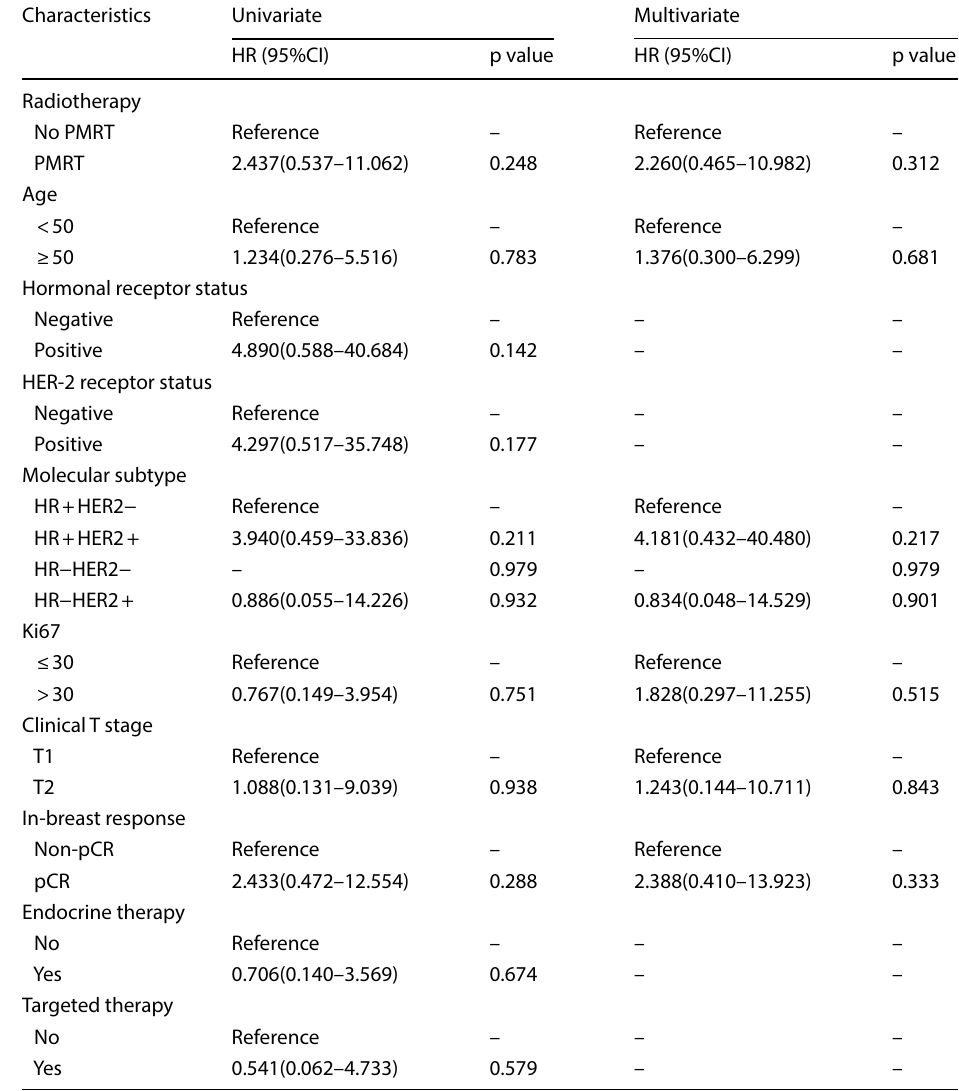
Table 2 Univariate and multivariate analyses of disease-free survival for all included